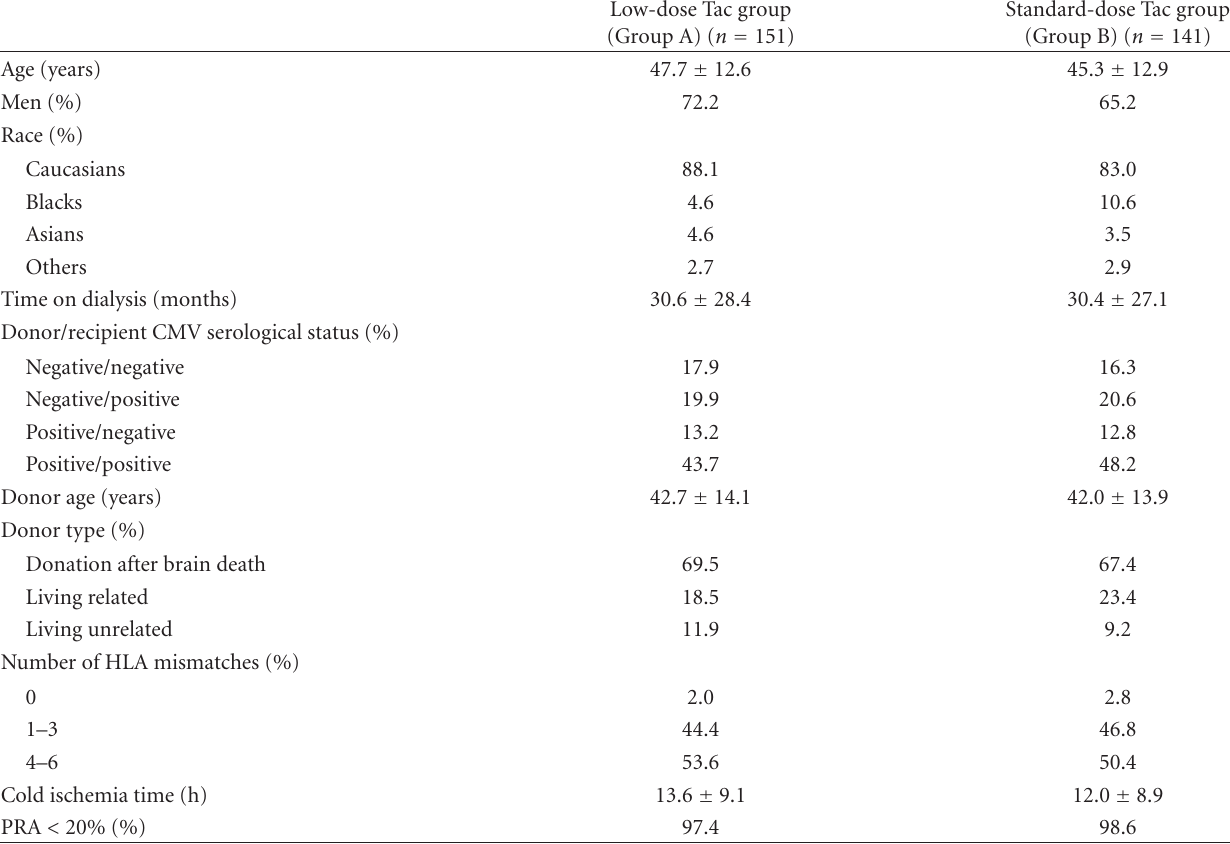
Table 1: Demographic and baseline characteristics between the treatment groups (ITT